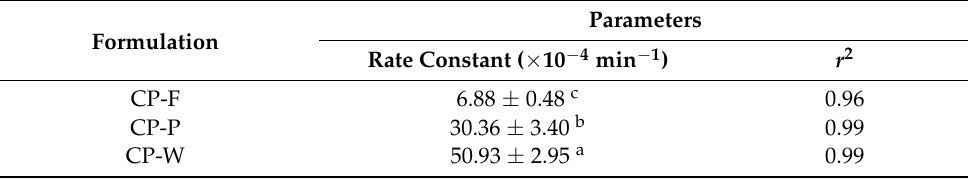
Table 3. First order parameters of CP degradation under UV light exposure.